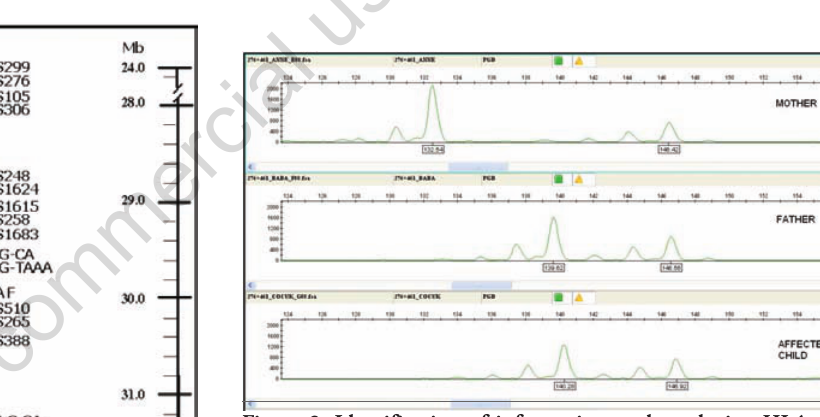
Figure 2. Identification of informative markers during HLA set up study.